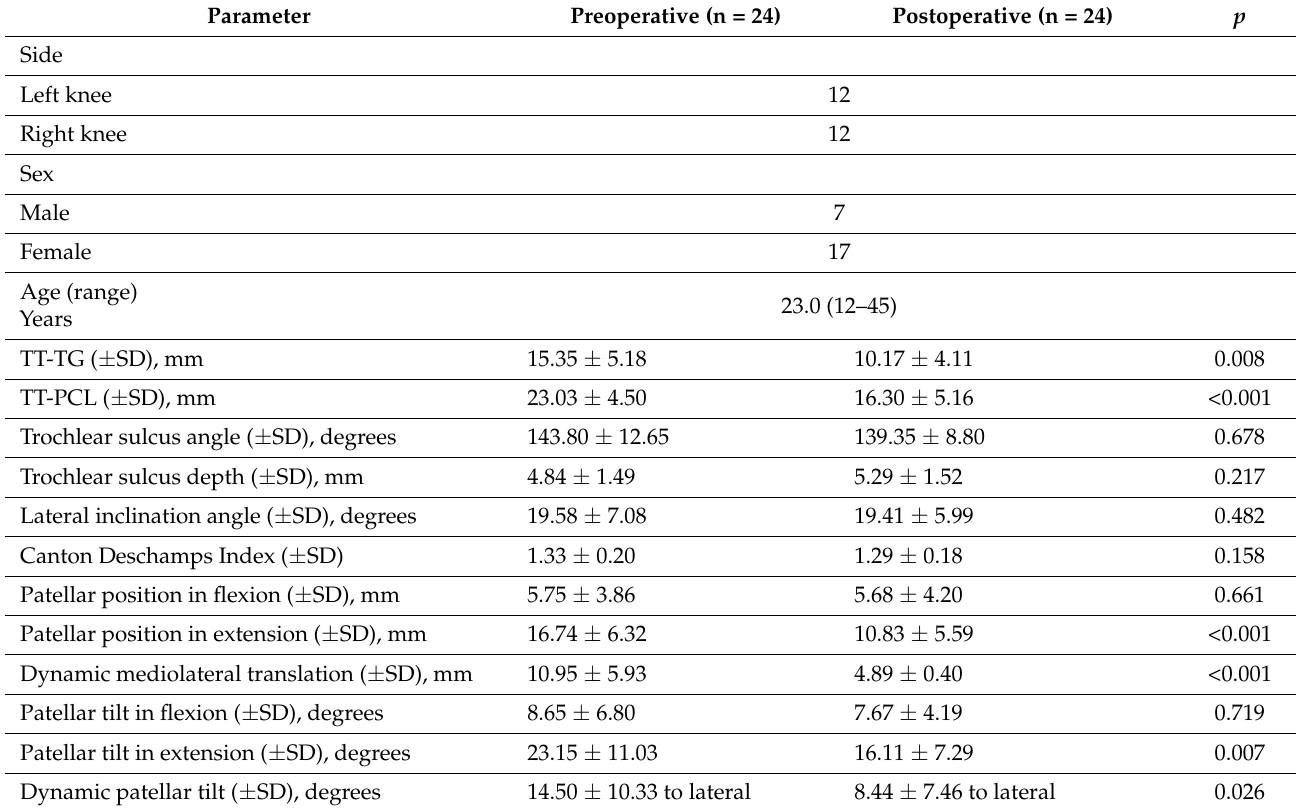
Table 2. Mean descriptive data of the static and dynamic parameters for patellar tracking in the study